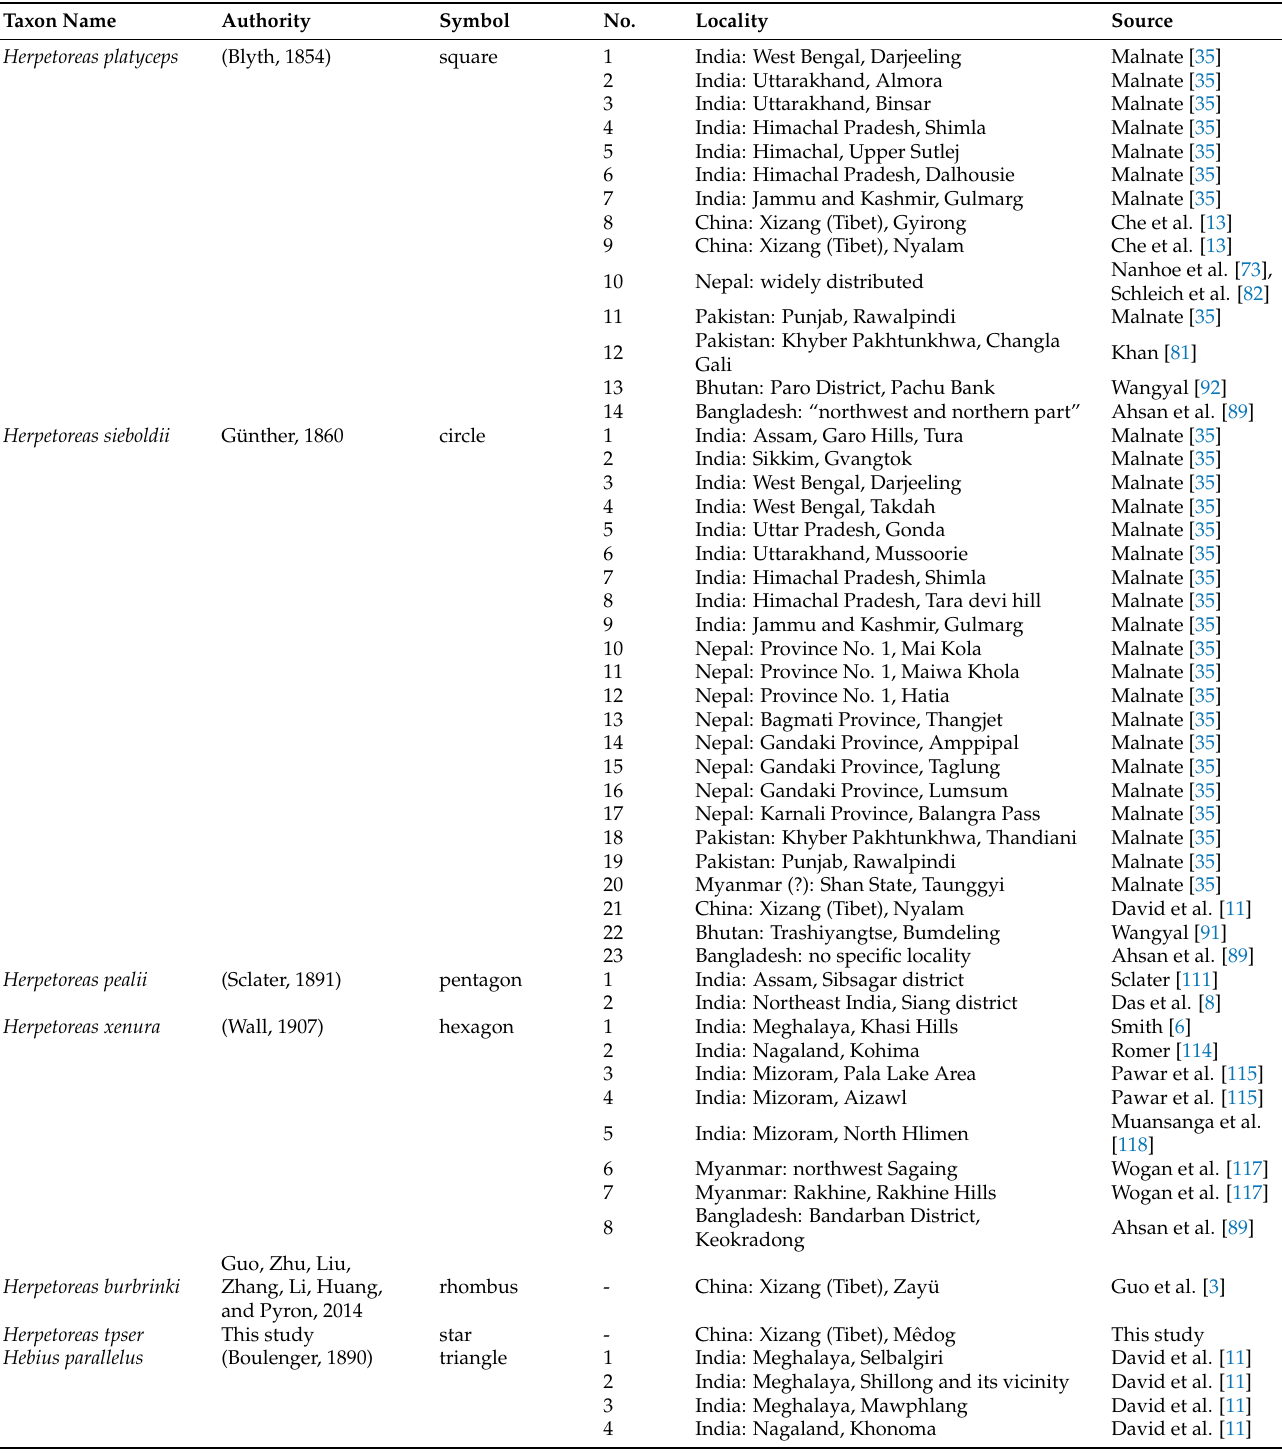
Table A1. Detailed information of the distribution sites showed in Figure